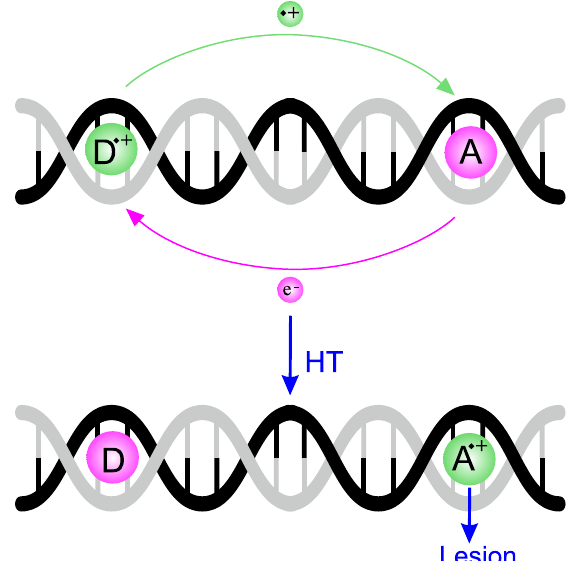
Figure 1. Schematic representation of the hole transport in DNA. The first ionization takes place at the donor site (D), where a hole is generated. The hole migrates through the double helix of DNA, reaching the acceptor site (A), where the final irreversible oxidative damage (lesion) occurs. Aside from B-DNA, a very efficient hole transport has been observed also in guanine quadruplex stacked sequences adsorbed on a mica substrates [25]. Indeed, in recent years, growing attention has been given to the oxidation of G-quadruplexes, for they occupy telomeric regions of chromosomes, often found in oncogene promoter sequences